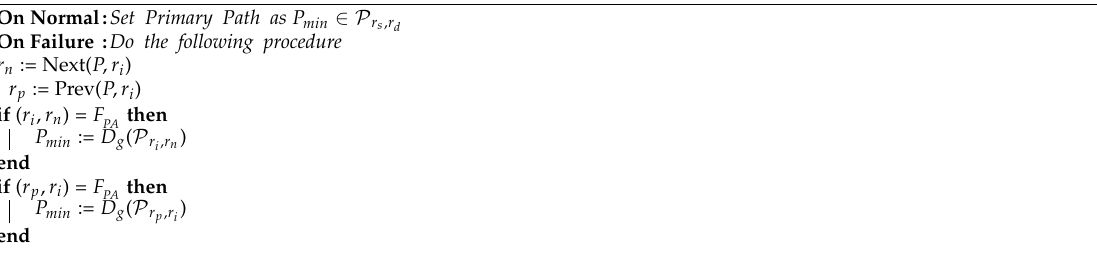
Algorithm 4 Find the Shortest Path with Dijkstra’s from Node-to-Node in a Graph